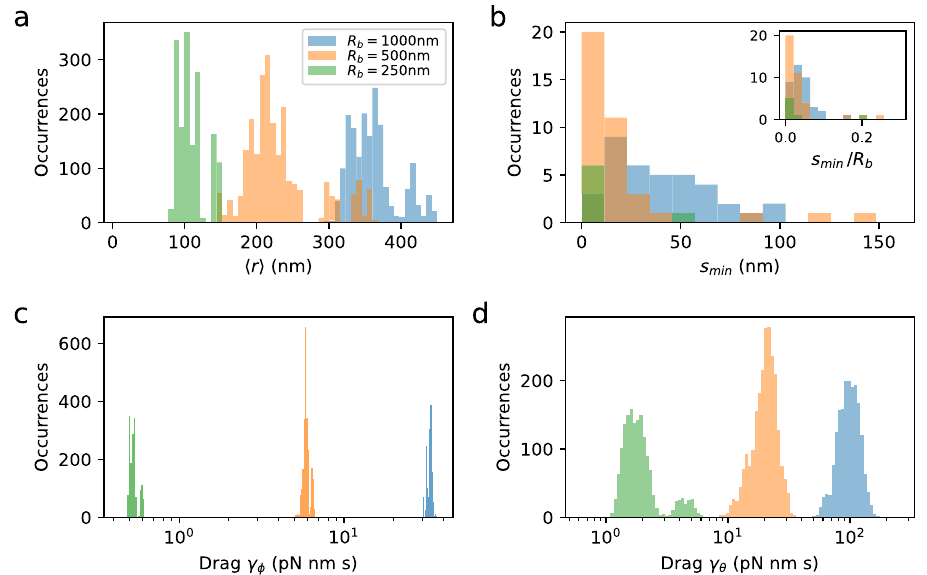
Fig. 4 Experimental distributions of parameters de fi ned in Fig. 2, obtained from the analysis of all the measured traces for the three loads considered. a Histograms of the average radius r i in each time-window of the x , y bead trajectories. b Histogram of the optimal value of the distance between the bead and the membrane s , where one value is obtained from the analysis of each trace. Inset: distributions of s min R b . c , d Distributions of the drag coef fi cients γ ϕ and γ θ , obtained in each time-window of all the traces. The color code, indicating the bead radius, is the same for all the panels. The measurements, each on a different cell, consist of 36, 35, and 7 traces for motors at steady state and 6, 13, and 6 resurrection traces for beads of radius R b = 1000, 500, 250 nm,